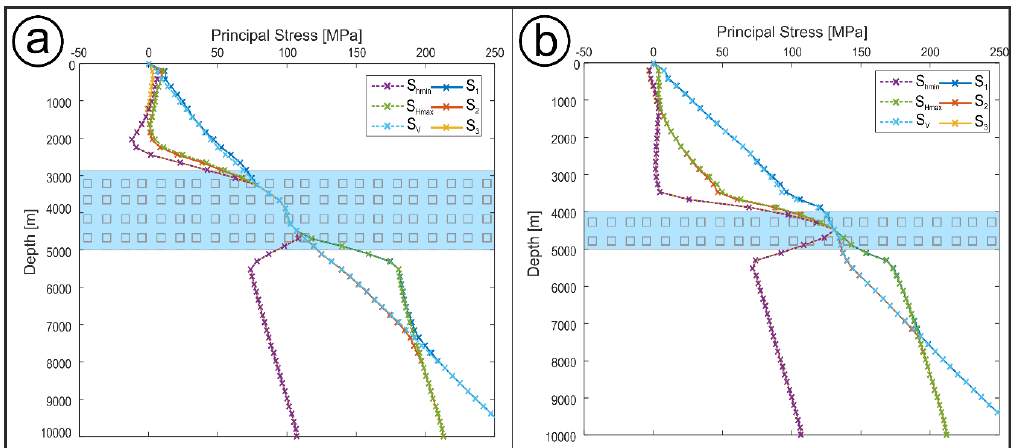
Figure 8 . Principal stress magnitudes for two hypothetical wells (W2 and W3) in the northern flank of the diapir of Model B-04c (Figure 2c). ( a ) W2—1500 m north of W1 in the middle of the diapir flank. ( b ) W3—3000 m north of W1 and 1500 m north of ( a ) at the lower edge of the diapir flank.